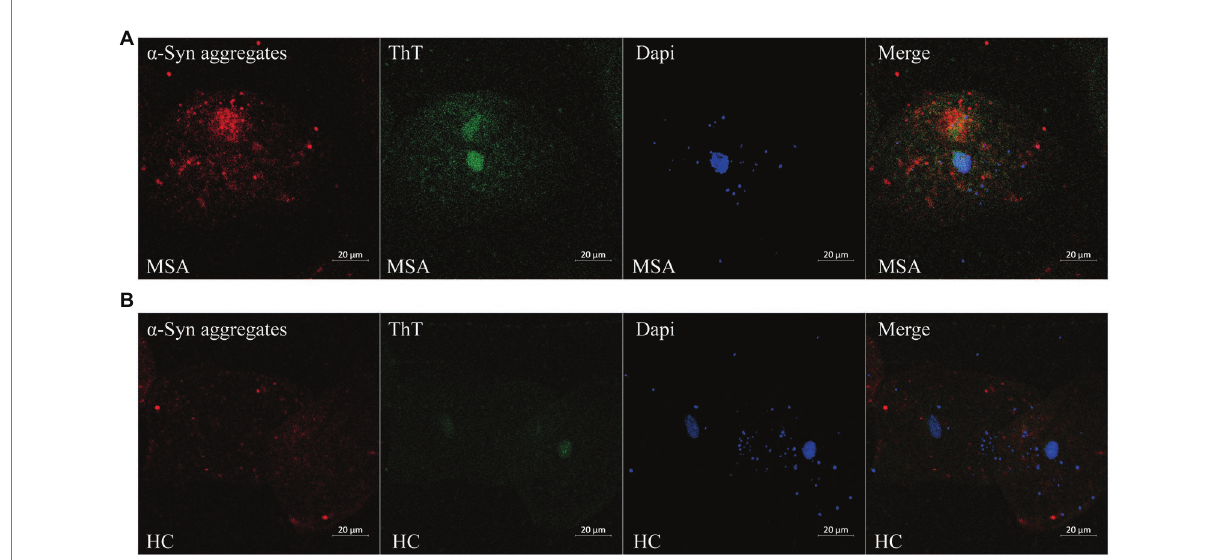
FIGURE 2 Confocal microscopy (×40) study of double immunofluorescence staining with ThT and MJFR-14-6-4-2 antibody in oral mucosal cells of MSA patients (A) and controls (B) . DAPI: bule. α -Syn aggregates: red. ThT: green. Scale bar: 20 μ m. MSA, Multiple System Atrophy; α -Syn, α -synuclein; ThT, Thioflavin T.